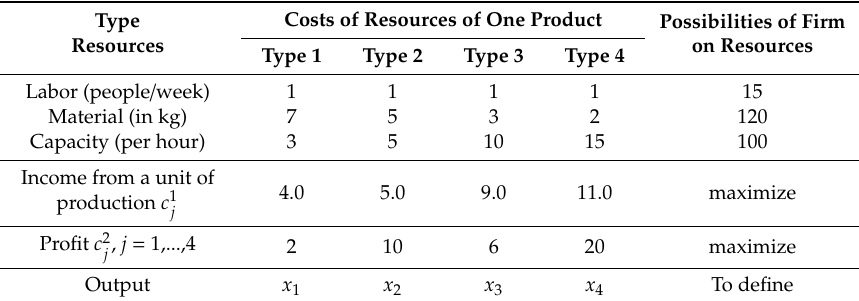
Table 1. The consumption of resources and operational